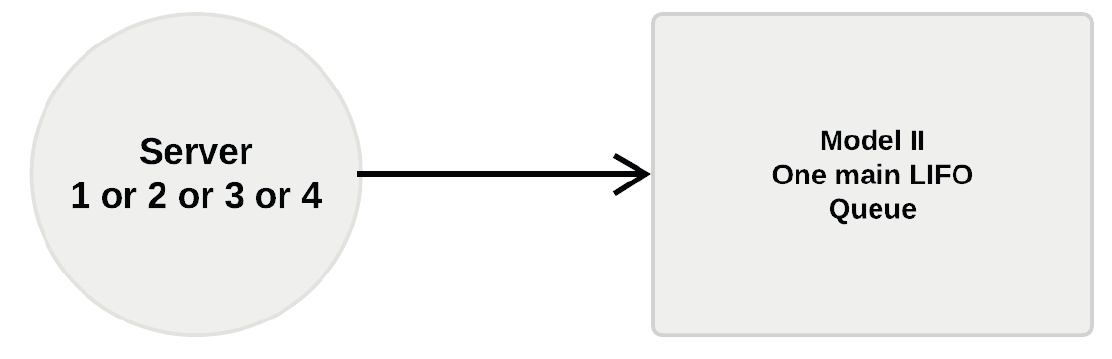
Figure 12. Block scheme of entities path to the main storage area in model